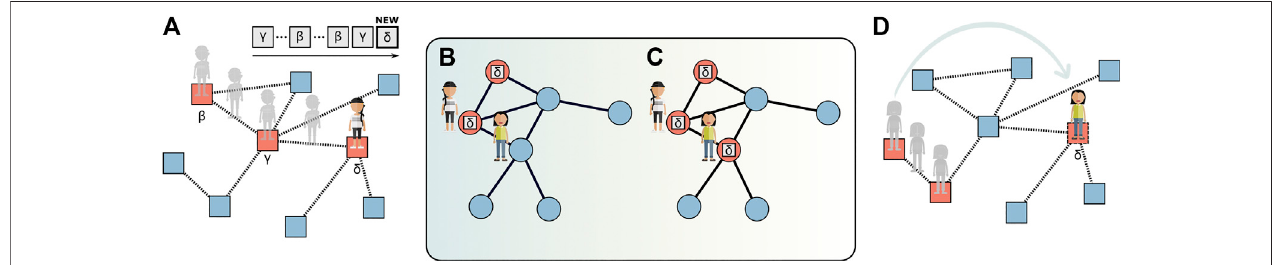
FIGURE 3 | Coupling the dynamics of discovery and contagion. (A) A walker explores the space of items. Every time a node is visited, the corresponding item is added to the sequence associated to the agent. Walking on δ represents the discovery of a novelty, since it never appeared in the sequence of before. (B) At this point, the new item δ can spread from the walker to his neighbors through the link of a social network following a process of social contagion. In particular, in (C) , a neighbor discovers δ through the social contagion dynamics. As a consequence, her position on the network of items is updated by means of a fl ight (D)